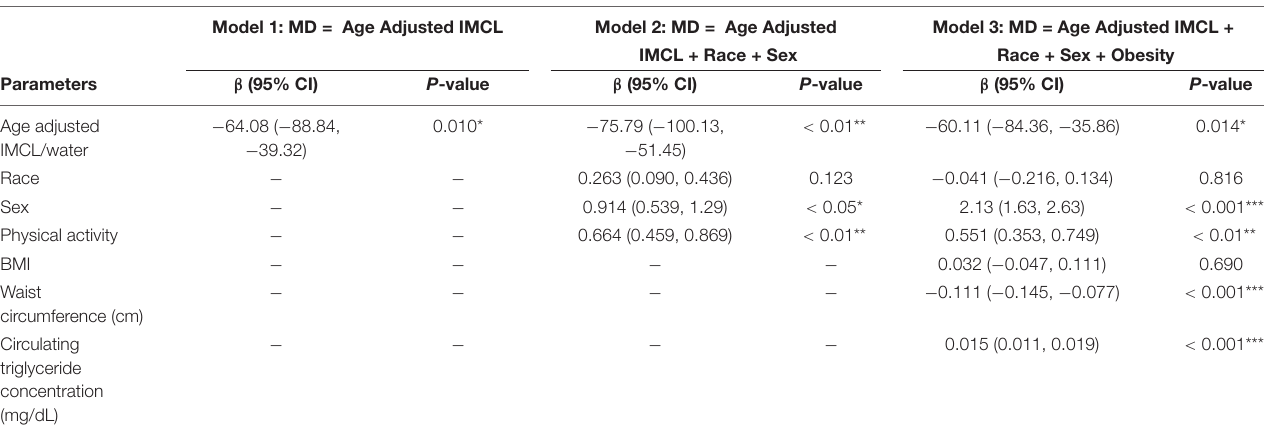
TABLE 3 | Multivariate analysis adjusting for confounding